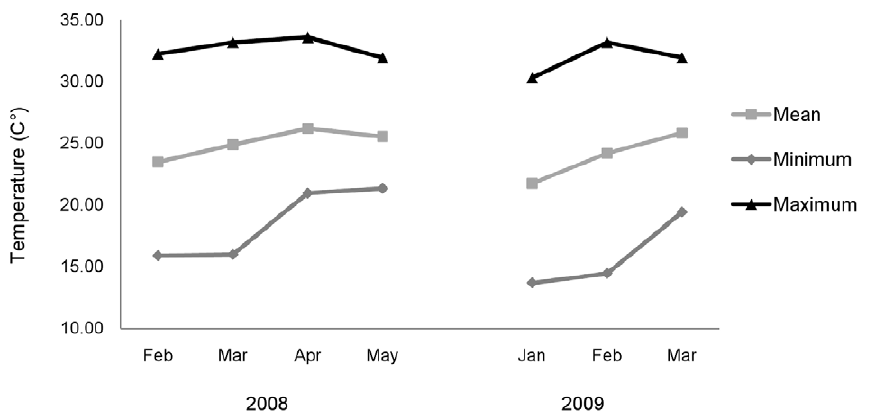
Figure 6. Mean, minimum and maximum nightly temperatures in the Seima Protection Forest during the study period.